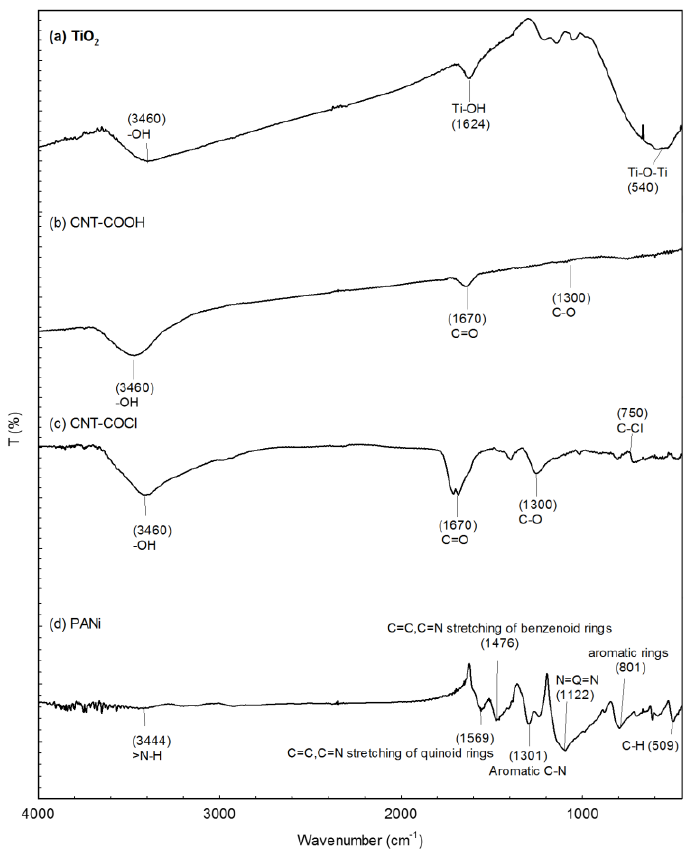
Figure 1. The Fourier transform infrared spectroscopy (FTIR) spectra of base materials for immobilized photocatalysts. (a) TiO 2 ; (b) CNT-COOH; (c) CNT-COCl; (d) PANi. photocatalysts. (a) TiO 2 ; (b) Carbon nanotubes (CNT)-COOH; (c) CNT-COCl; (d) Polyaniline